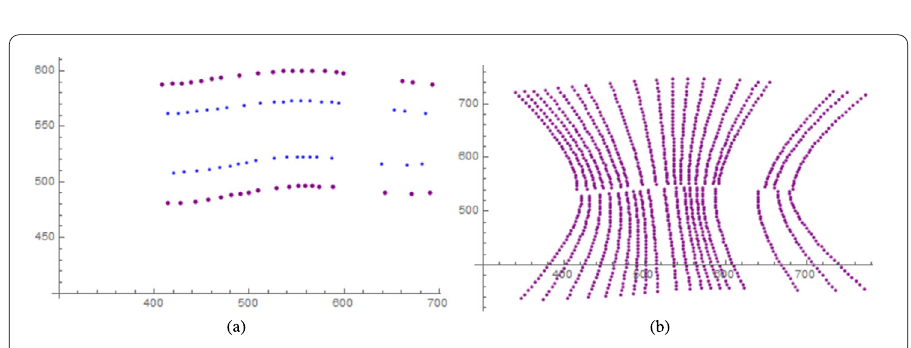
Figure 9 Reconstruction of the tunnel map ( γ = 5). ( a ) The snapshots of the larva swarm at the 5th step (in blue) and the 10th step (in purple); ( b ) the reconstructed tunnel